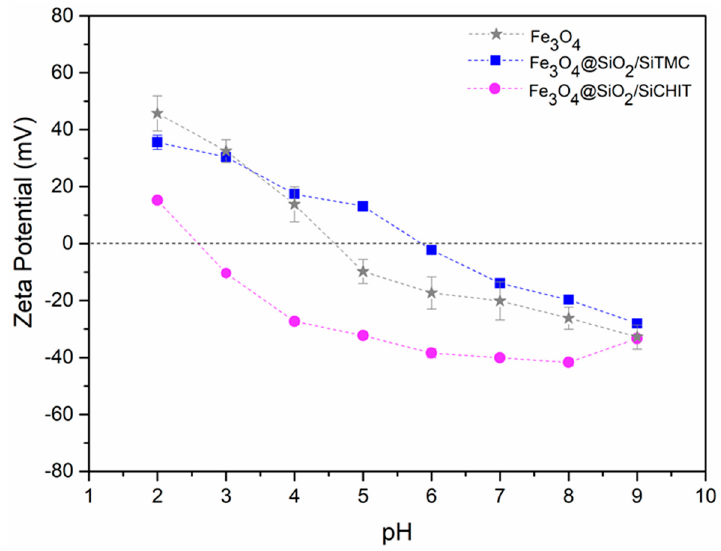
Figure 5. Zeta potential values of bare magnetite and coated particles at variable pH.